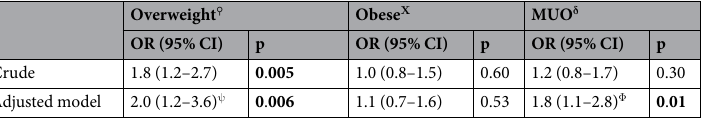
Table 3. Odds ratio (OR) for comparison of effects of social jetlag ( > 1 h) versus no social jetlag ( ≤ 1 h) on overweight, obese or metabolically unhealthy obesity (n = 792) ψ Multivariate logistic regressions analysis adjusted model for age, sex, employment status, insulin use, use of sleeping pills, use of antidepressants and time of diagnosis of type 2 diabetes mellitus, systemic arterial hypertension or dyslipidaemia. Φ Multivariate logistic regressions analysis adjusted model for age, sex, insulin use, use of sleeping pills, minutes of physical activity per week, and time of diagnosis of type 2 diabetes mellitus, systemic arterial hypertension or dyslipidaemia. ⚲ Overweight (BMI ≥ 25 kg/m 2 ). Χ Obese (BMI ≥ 30 kg/m 2 ). δ MUO (BMI ≥ 30 kg/m 2 and high-risk values on three or more biomarkers for metabolic syndrome). CI: confidence intervals. MUO: Metabolically unhealthy obese. OR: odds